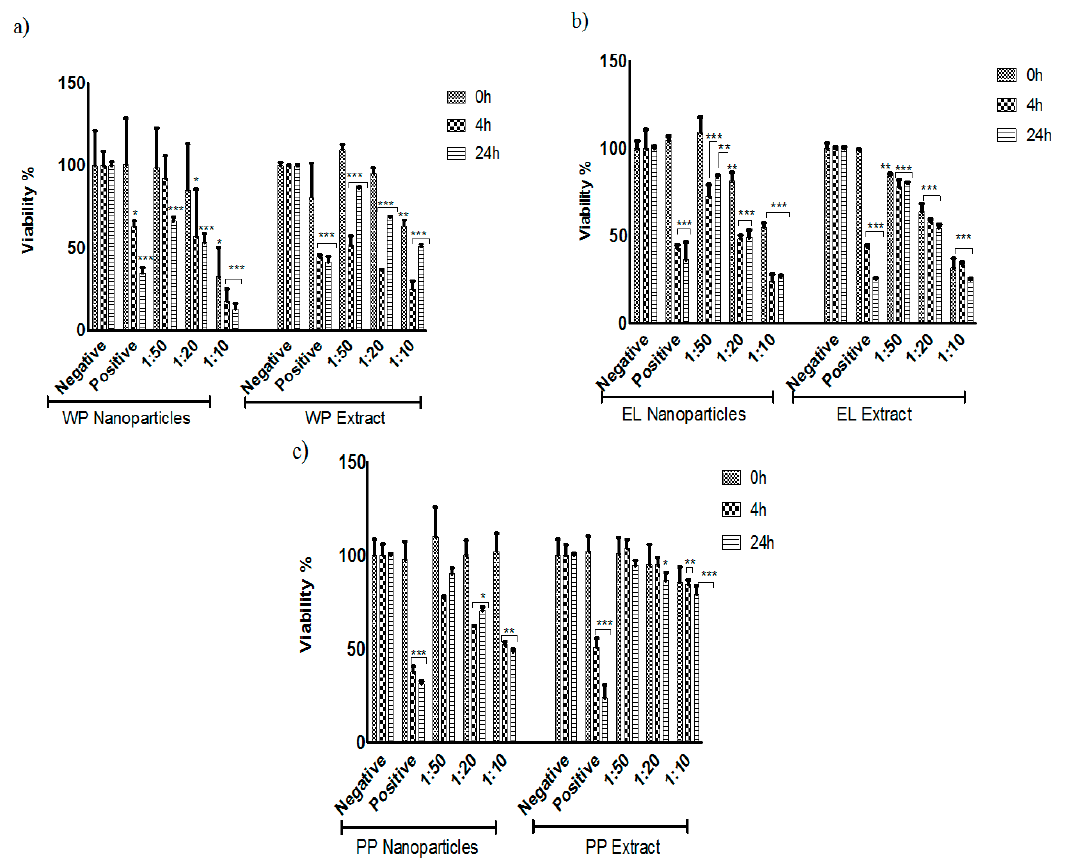
Figure 4. Activity against C. albicans . Nanosized and whole plant extract Cynomorium ( a ); nanosized and extract of external layer of Cynomorium ( b ); nanosized peeled part of Cynomorium and extract of the peeled part (PP) of Cynomorium ( c ). Values represent means ± S.D. * p < 0.05, ** p < 0.01 and *** p < 0.001.